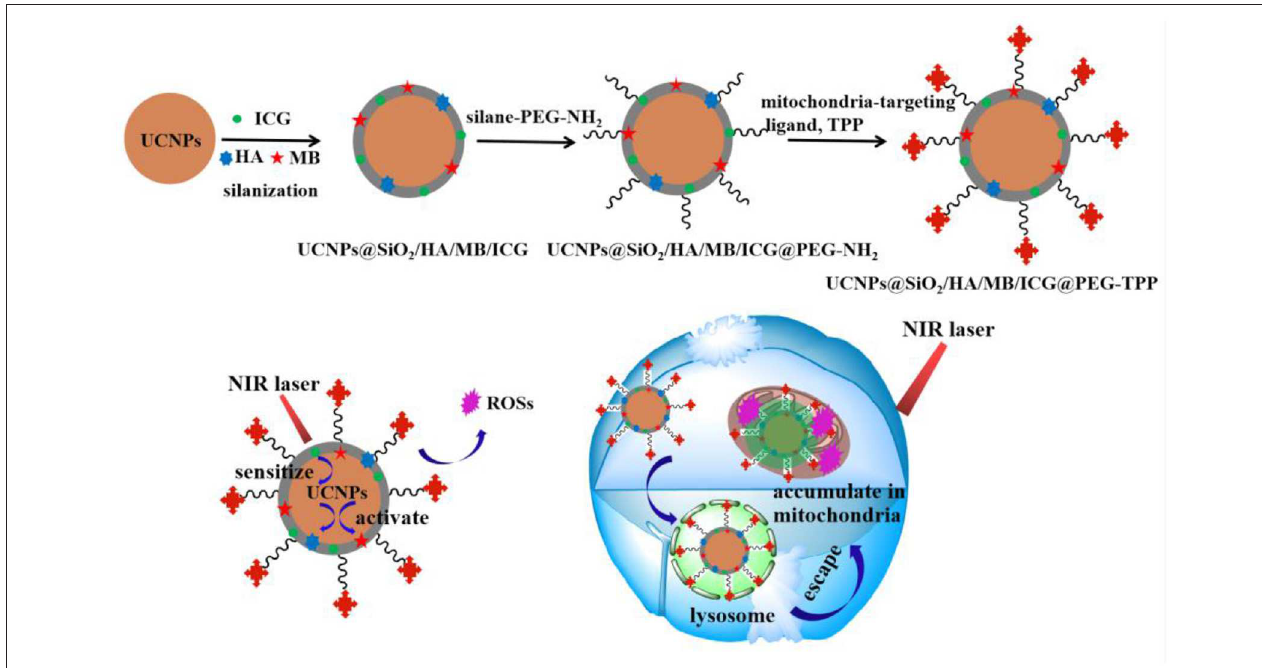
SCHEME 1 | Schematic image for the synthetic procedure of the UCNPs@SiO 2 /HA/MB/ICG@PEG-TPP nanotheranostic agent and its theranostic functions for the photodynamic therapy.